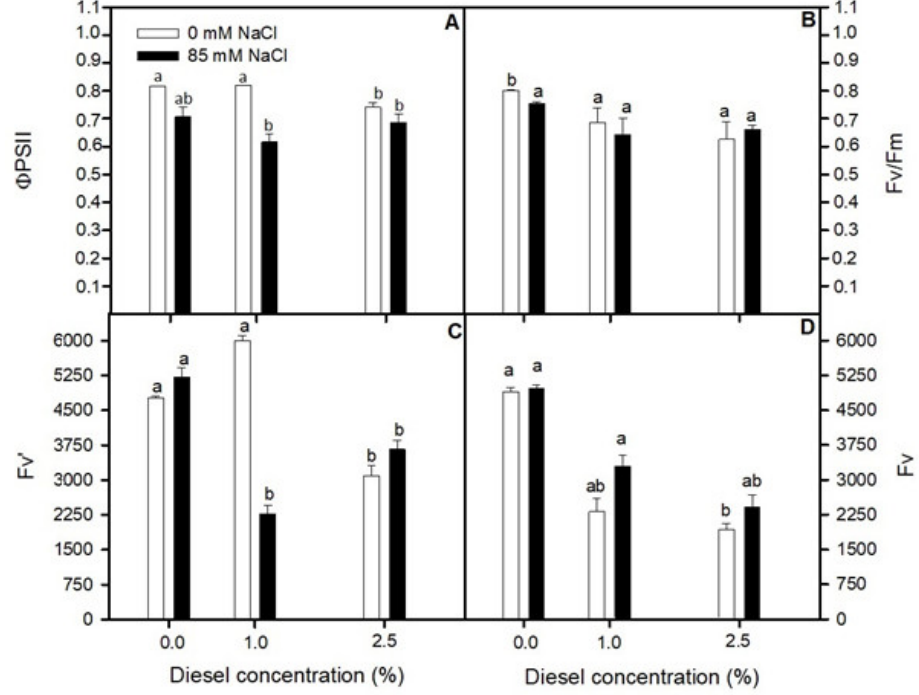
Figure 2. Maximum quantum efficiency of PSII photochemistry, Fv/Fm ( A ), Light and dark-adapted quantum yield of primary photochemistry, equal to the efficiency by which a PS II trapped photon will reduce QA to QA, ΦPSII ( B ), variable fluorescence (Fv) ( C ) and relative variable fluorescence (Fv’) ( D ) in dark-adapted randomly selected, primary branches of Juncus acutus in response to treat- ment with a range of diesel concentrations at 0 and 85.5 mM NaCl for 20 d. Values represent mean ± SE, n = 7. Different letters indicate means that are significantly different from each other (LSD, p < 0.05). 2.3. Effects of Diesel and NaCl on Kautsky Curves Parameters The OJIP curve (Figure 3) showed similar variable fluorescence values for plants grown at 0 and 85 mM NaCl at 0% of diesel. The maximum fluorescence reached had a decrease of almost 65% at 1% of diesel when the NaCl was added to the grown solution. In plants grown at 2.5% of diesel, the decrease was seen at both salinities being more ac- cused at 0 mM NaCl than at 85 mM NaCl. ABS/CS values did not show differences with the diesel concentration at both salinities (Figure 4A) (GLM ABS/CS p > 0.05 F = 1.945076). However, the absorbed energy flux (ABS/CS) showed values significantly higher for plants grown at 0 mM NaCl than for those grown at 85 mM NaCl at 1% diesel (LSD test p < 0.05). Trapped (TR/CS) and transported (ET/CS) energy fluxes followed a similar trend for plants grown at 1% diesel (Figure 4B,C). In addition, in both parameters a significant effect of both NaCl and diesel were found (GLM TR/CS NaCl p < 0.05 F = 4.86 Diesel p < 0.01 F = 10.17, GLM ET/CS NaCl p < 0.05 F = 6.36 Diesel p < 0.01 F = 22.19). Moreover, both of them were higher for plants grown at 85 mM NaCl than for plants grown in the absence of NaCl at the highest diesel concentration (LSD test p < 0.05). Dissipated energy flux (DI/CS) in- creased with diesel concentration significantly in plants grown at 0 mM NaCl reaching its maximum values at 2.5% diesel (Figure 4D) (GLM DI/CS Diesel p < 0.01 F = 8.87). At 85 mM NaCl, it remained at similar values for all diesel concentrations tested and showed lower values than in the absence of NaCl overall (LSD test p > 0.05).